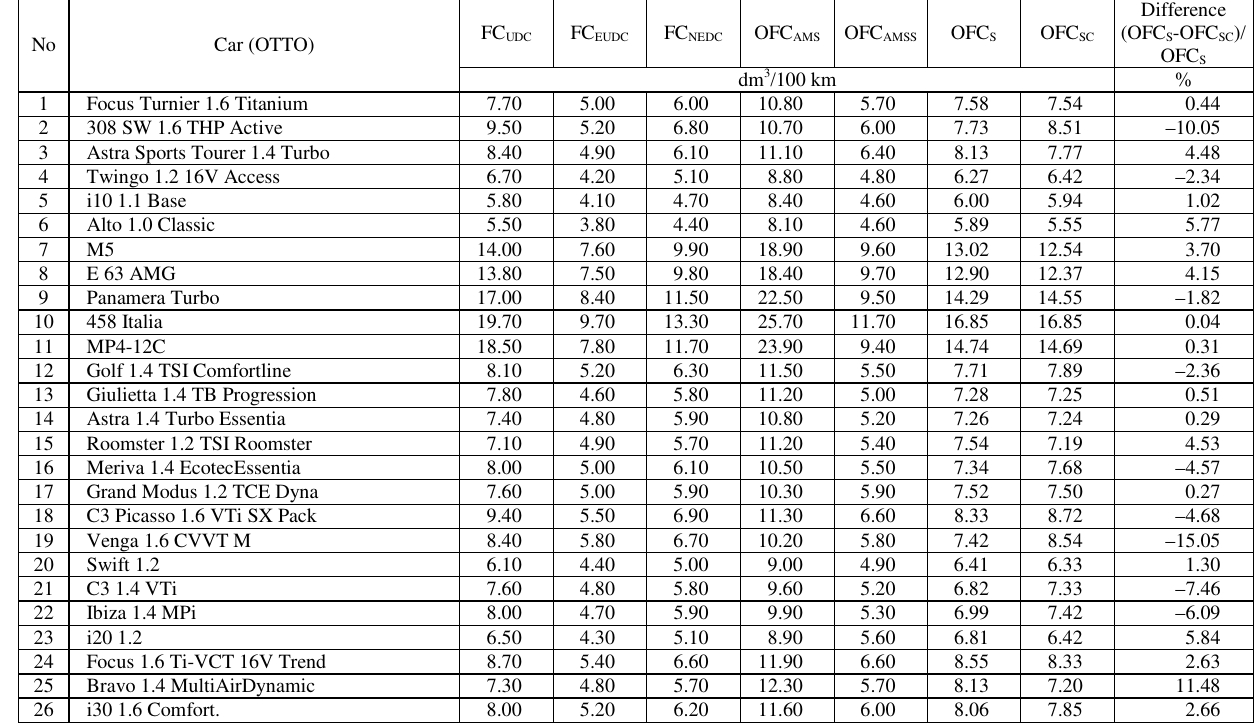
Table 2. The measurements and calculation results of fuel consumption in the braking and route tests of vehicles with spark ignition engines (Otto) FC UDC FC EUDC FC NEDC No Car (OTTO) Focus Turnier 1.6